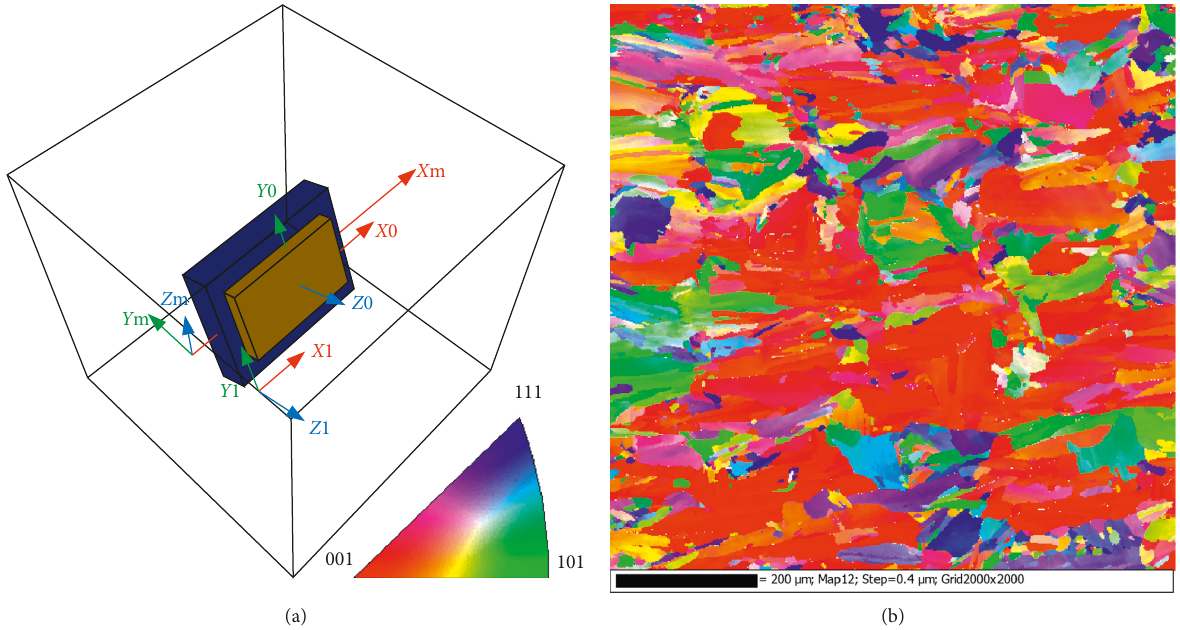
Figure 10: (a) Sample configuration and principal axes in the microscope chamber and (b) IPF- Y 0 inverse pole figure grain map of the scanned area on the side wall of the sample oriented at 90 ° with respect to the build plate. The EBSD patterns were acquired with 0.4 μ m step size.